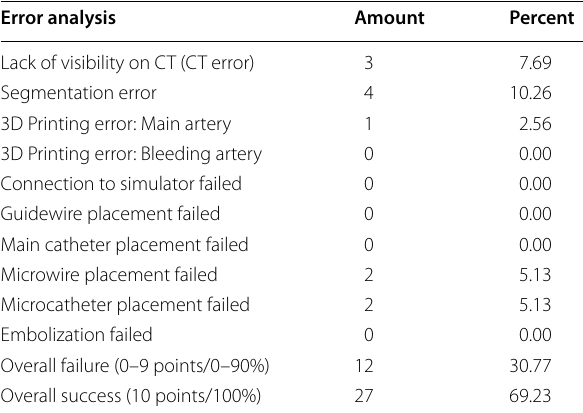
0.031) and significantly increased in soft =